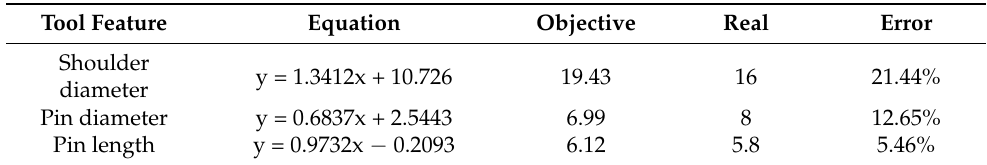
Table 7. Comparison between tool design guidelines and experimental work by other authors for series 6XXX.